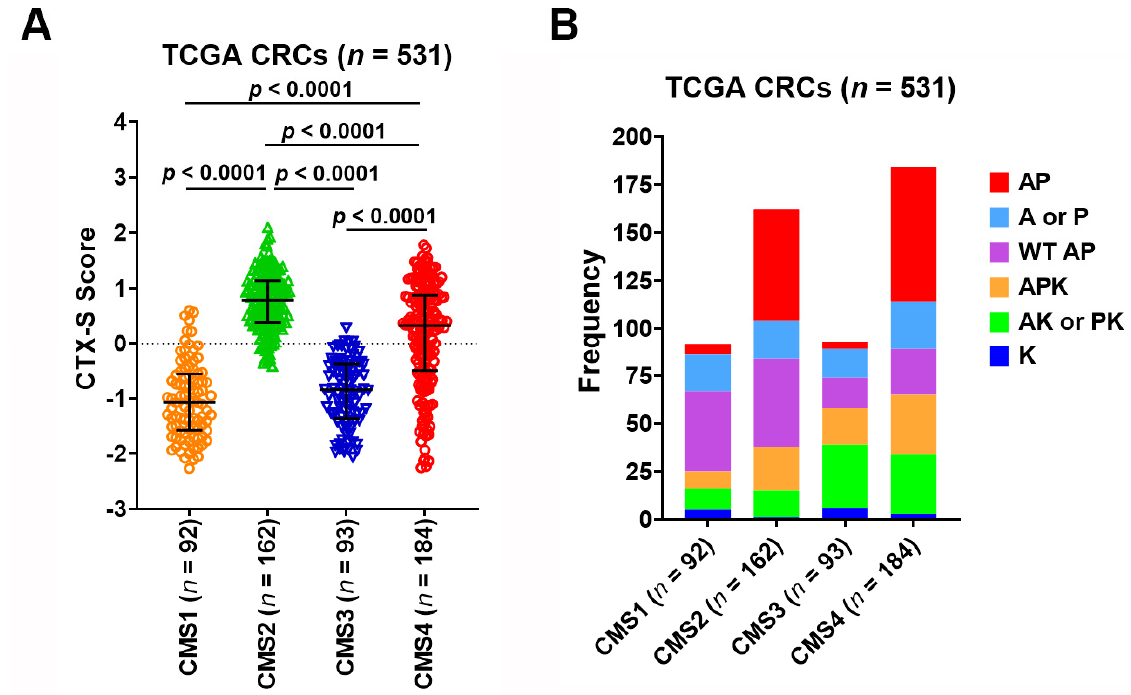
Figure 5. ( A ) Comparison of CTX ‐ S scores among four CMS classes in TGCA CRC tumors. Bars represent median with interquartile range. p values are for two ‐ tailed Welch t test. ( B ) Frequencies of six subgroups of MUT APC (A)/MUT TP53 (P)/MUT KRAS (K) across CMS1 ‐ 4 classes.